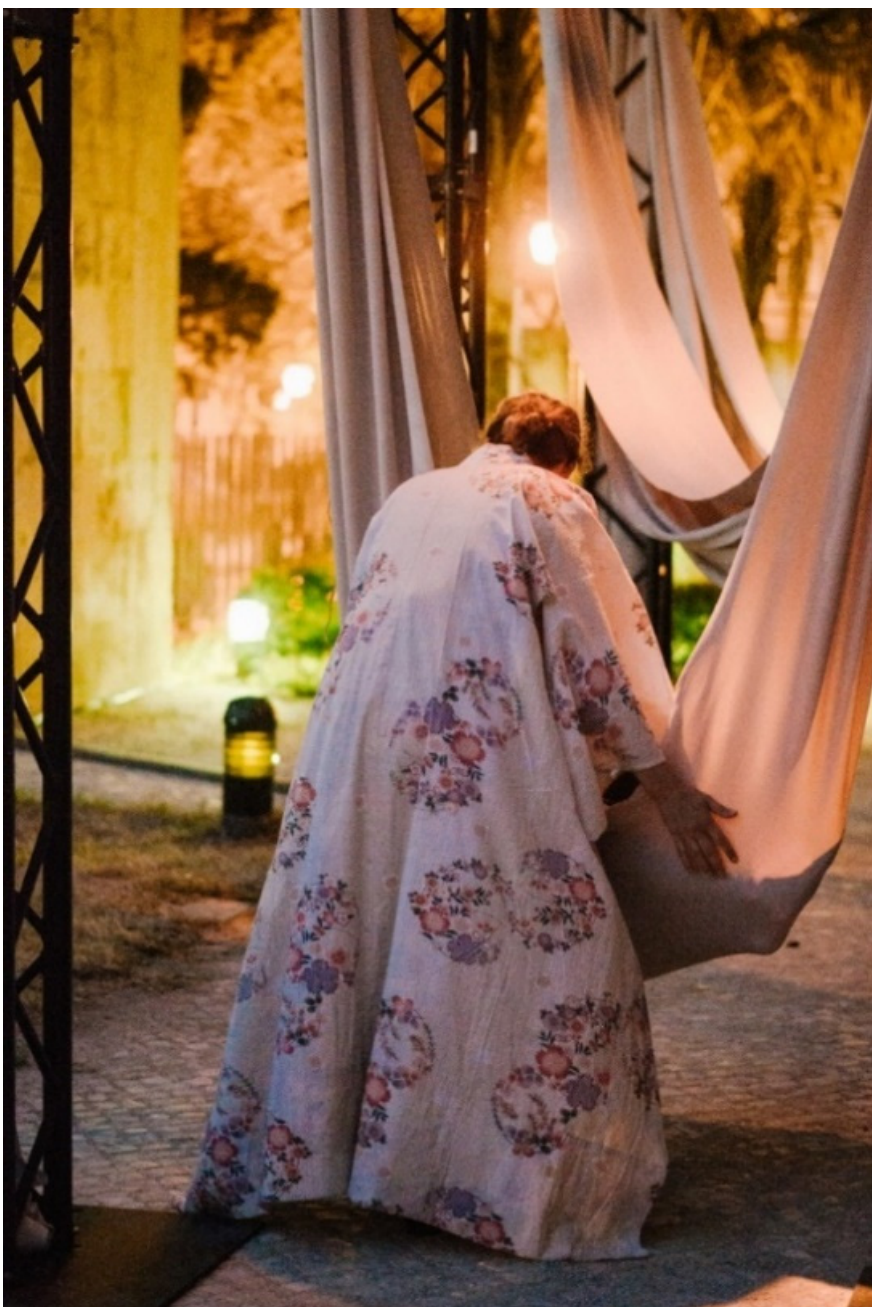
Figure 4. Place of Sleep . Suspended hammocks and performer Célia Fechas wearing long costume. Mãe d’Água das Amoreiras Reservoir, Lisbon, 2019. © Joana Linda.